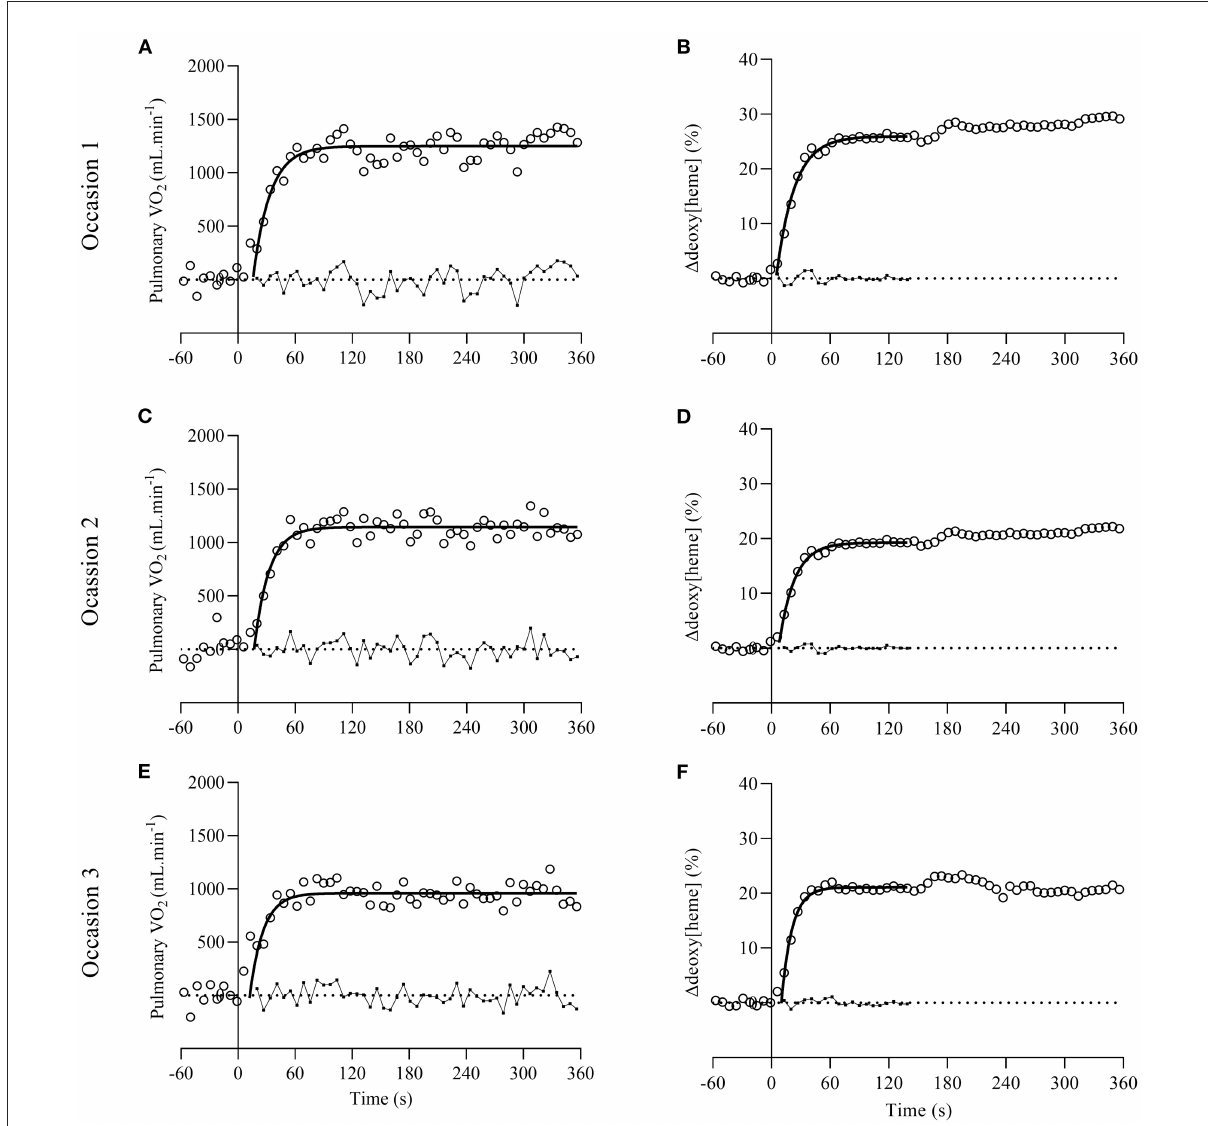
FIGURE1 Representative plots of pulmonary ˙VO 2 [open circles on (A,C,E) ] and muscular 1 deoxy[heme] on-kinetics [open circles on (B,D,F) ] from one participant on occasion one, two, and three. Dotted lines represent baselines where pulmonary ˙VO 2 and 1 deoxy[heme] is zero. Solid lines and small full circles with connective lines represent the exponential curve fits and residuals,